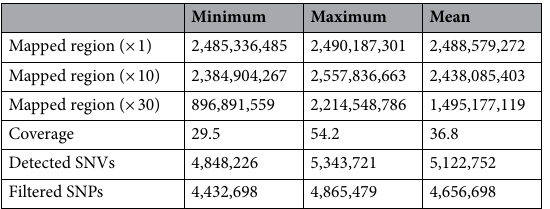
Table 1. Minimum, maximum, and mean numbers of mapped sequence reads and SNVs detected in 101 Thoroughbred